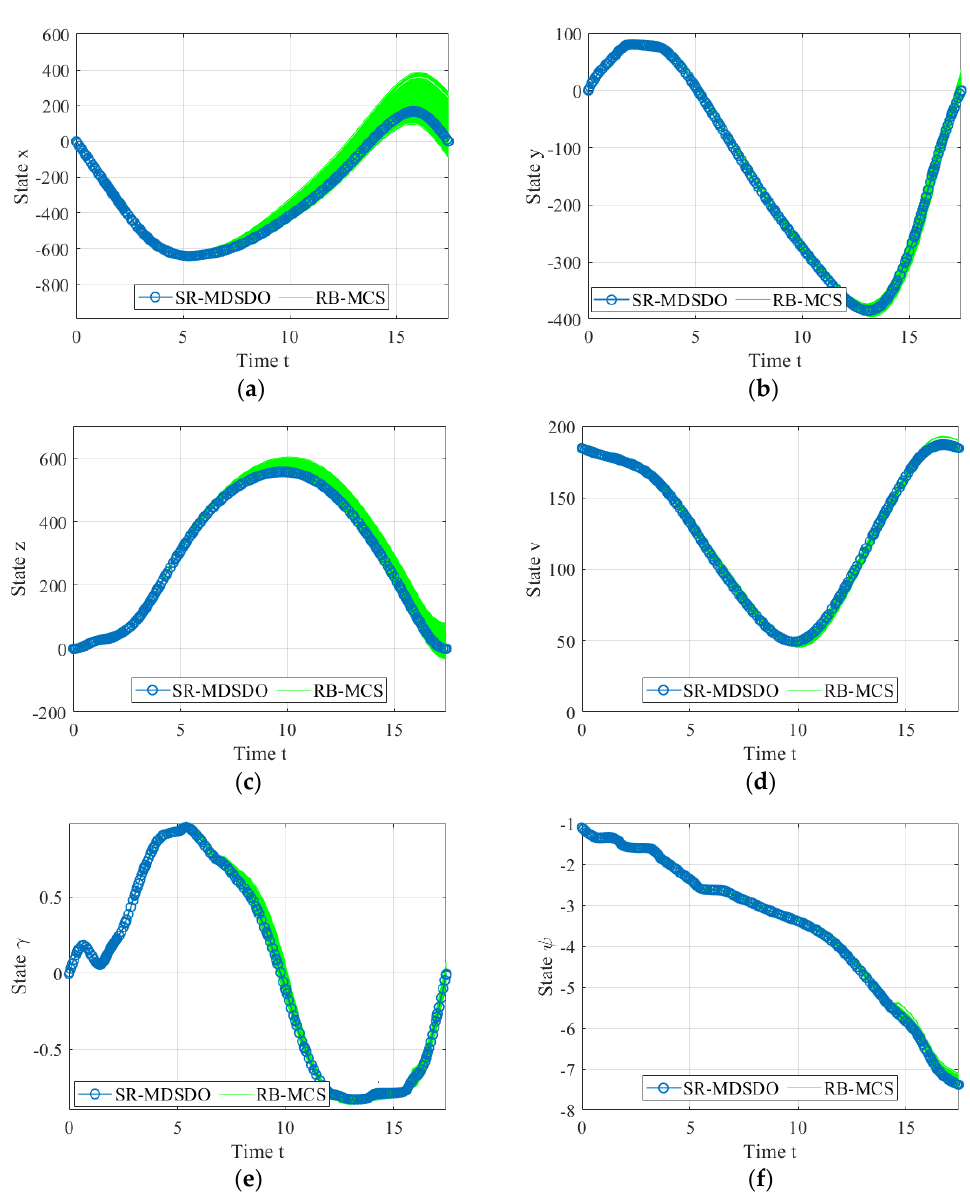
Figure 10. The uncertainty influence on state trajectories under C-MDSDO. ( a ) State trajectories of x . ( b ) State trajectories of y . ( c ) State trajectories of z . ( d ) State trajectories of v . ( e ) State trajectories of γ . ( f ) State trajectories of ψ